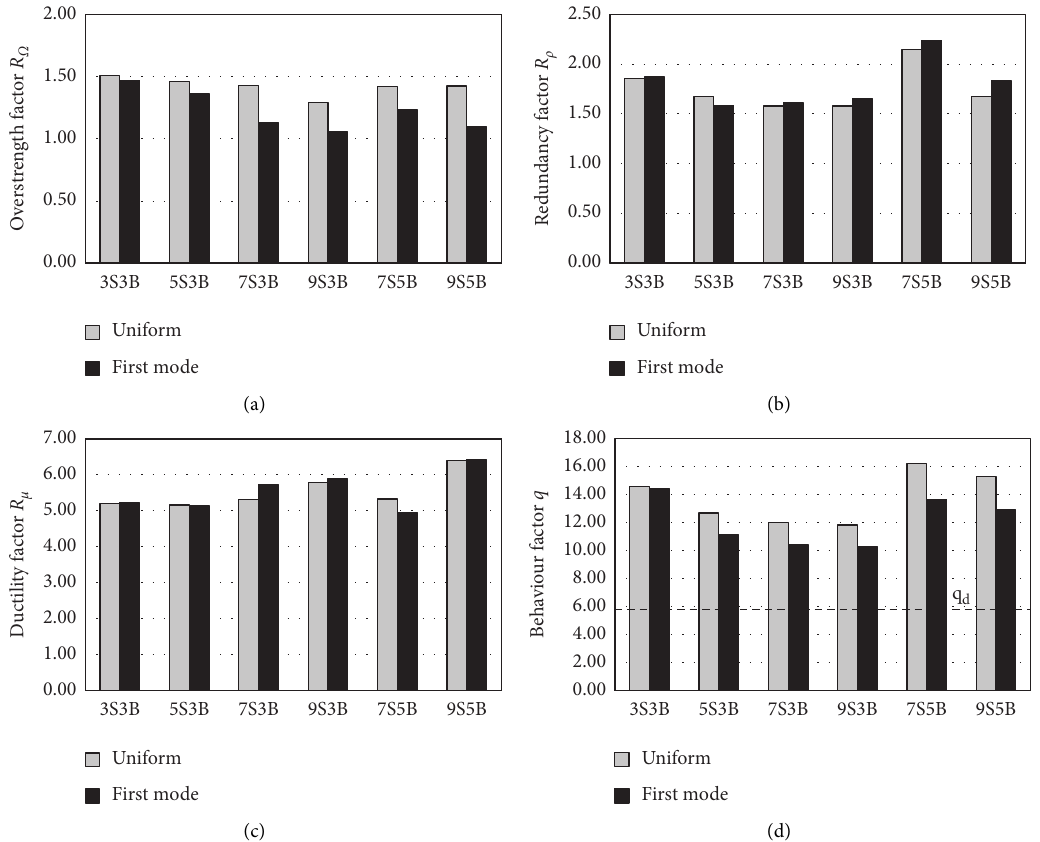
Figure 11: Overstrength ( R Ω ), redundancy ( R ρ ), and ductility ( R μ ) reduction factors and behaviour factor ( q